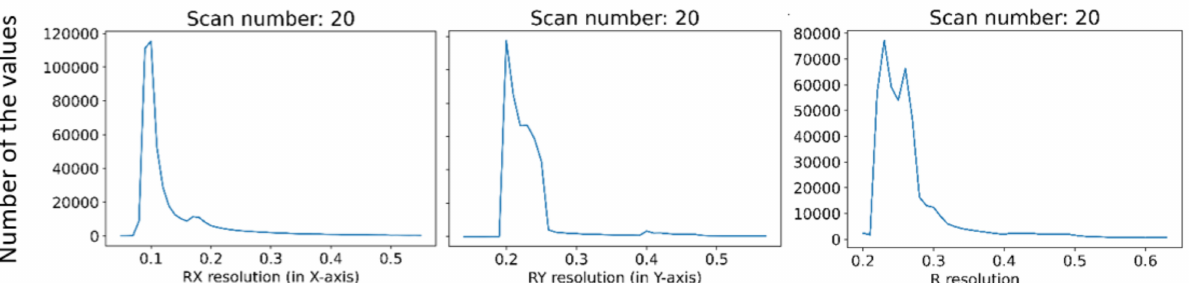
Figure 19. Resolutions for Scan